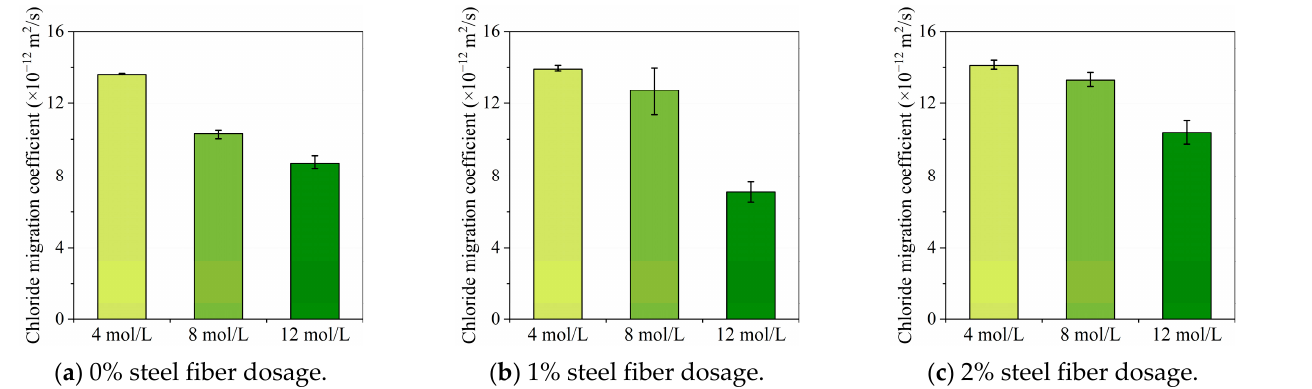
Figure 9. The influence of NaOH solution concentration on chloride migration coefficient tested using RCM.